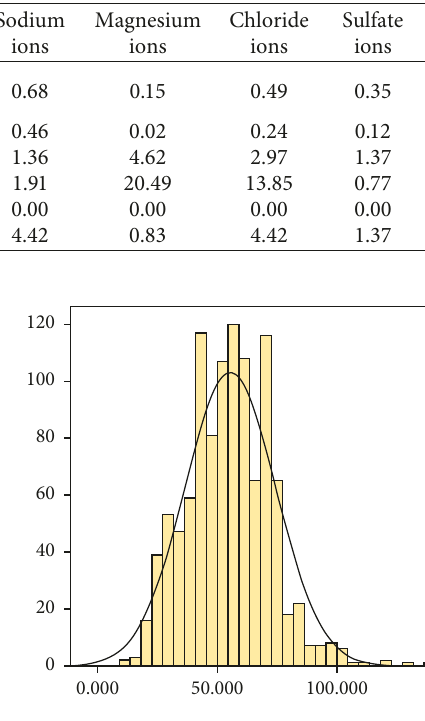
Figure 2: Distribution of final